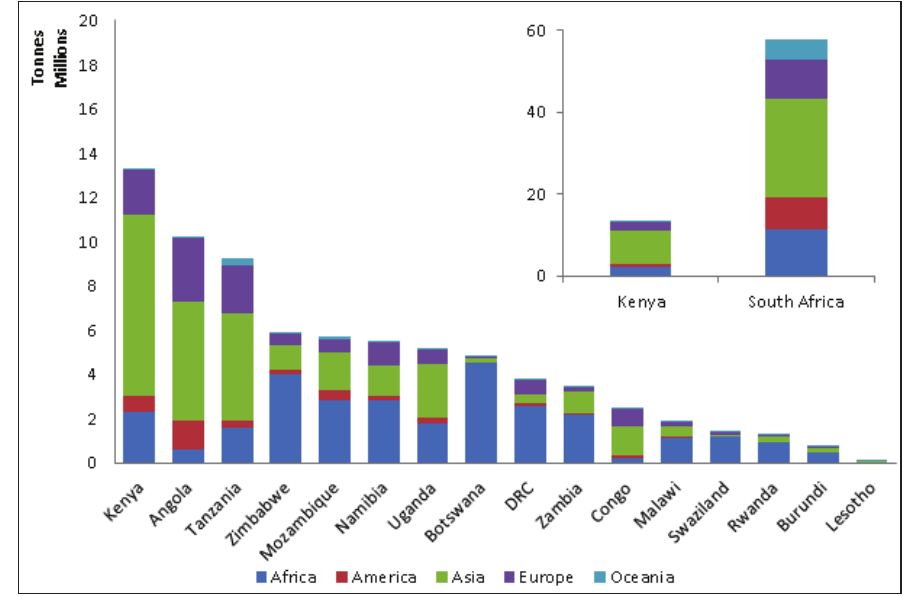
Figure 5: Import volumes from the five continental groups for 2010